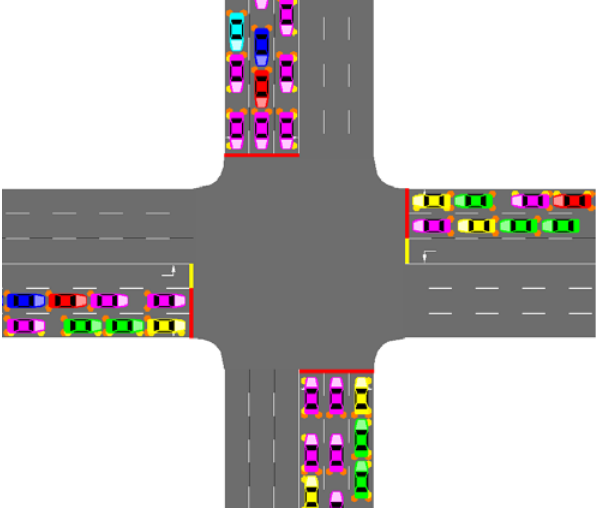
Figure 4. Intersection area with platoons in mixed traffic.